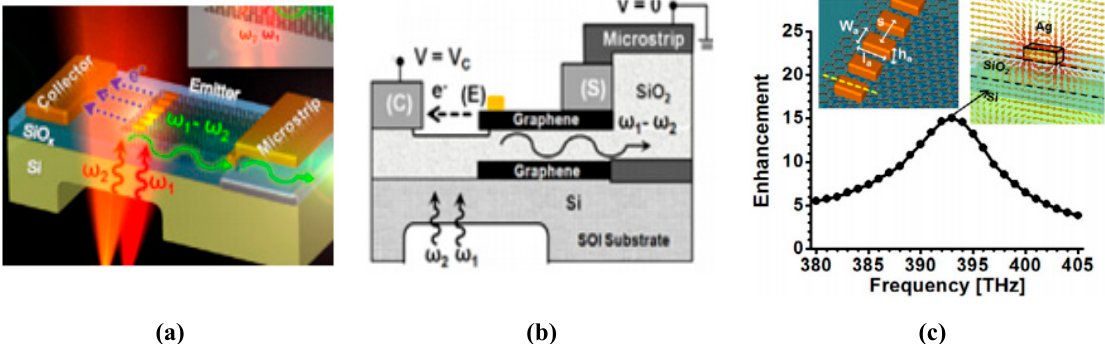
Figure 9. ( a ) Graphene optical antenna model excited by laser beams; ( b ) cross-sectional view of graphene patches integrated with photomixer; ( c ) enhancement of averaged optical field versus frequency, where the silver antenna array on the graphene sheet has a better enhancement factor and electric field distribution at the point of contact. © 2013 IOP. Reprinted with permission from [122].